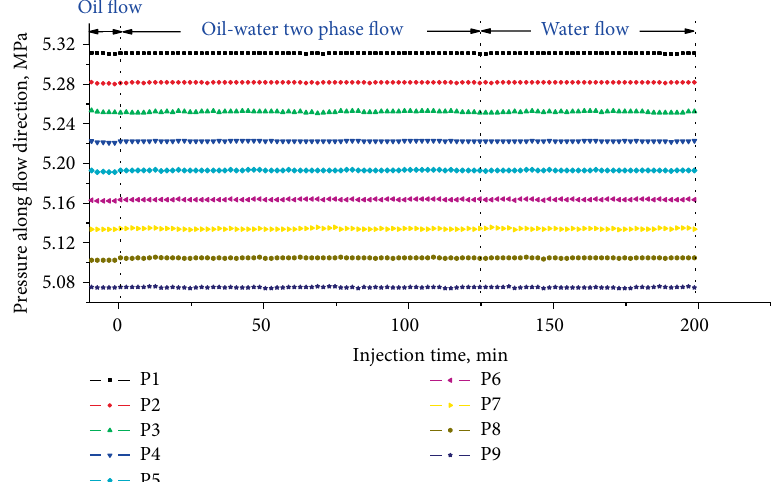
Figure 8: The relationship between pressure along flow direction and injection time in conventional sandstone reservoirs. The P1–P9 indicates the pressure at different locations of samples. over time. The pressure curves schematic of monitoring points (P2-P8) are presented in Figure 11. The pressure decreases to “valley bottom” in the left side and the pressure increase from “valley bottom” in the right side. There is a common feature between the left and right side that the rate of pressure change